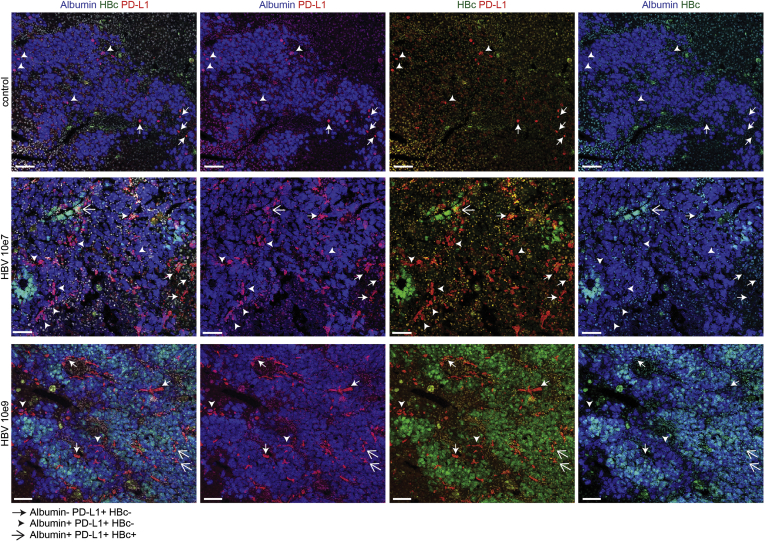
Immunofluorescence analysis of liver sections from HIS-HUHEP control or HBV-inoculated mice at either low dose (HBV 10e7) or high dose (HBV 10e9) co-stained for hAlbumin (blue), HBc (green), and PD-L1 (red) with DAPI-stained nuclei shown in grey. Scale bar represents 100 μm. In the second, third, and fourth vertical panels 1 color channel has been removed to visualize the staining patterns by pairs. White arrowheads: double-stained cells for Albumin and PD-L1; white open arrows: triple-stained cells for Albumin, HBc, and PD-L1; white filled arrows: cells mono-stained cells for PD-L1.